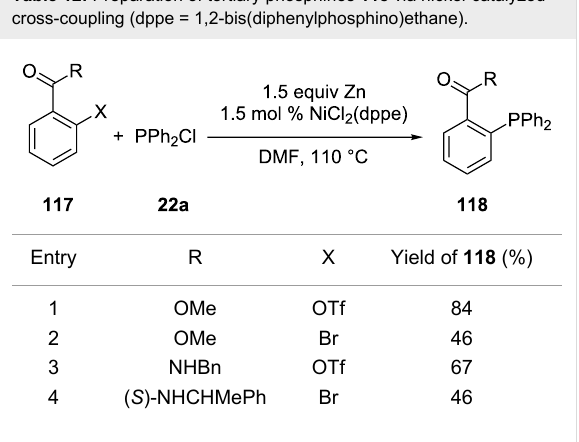
Table 12: Preparation of tertiary phosphines 118 via nickel-catalyzed cross-coupling (dppe =